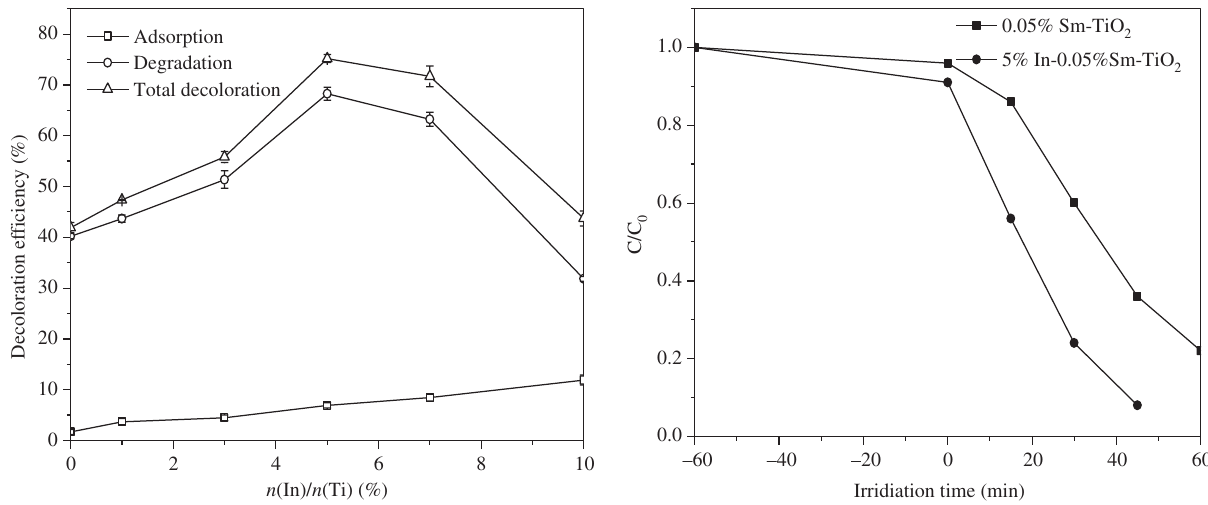
Figure 6: Adsorption and photocatalytic activities of x In-0.05%Sm- samples with respect to indium contents. TiO 2